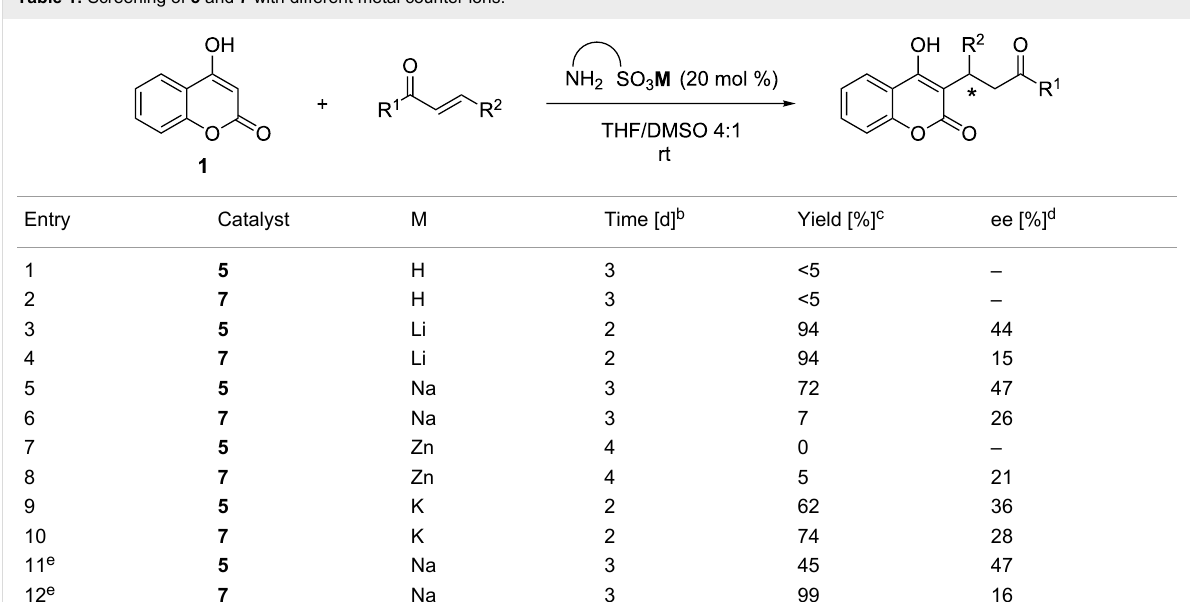
Table 1: Screening of 5 and 7 with different metal counter ions.